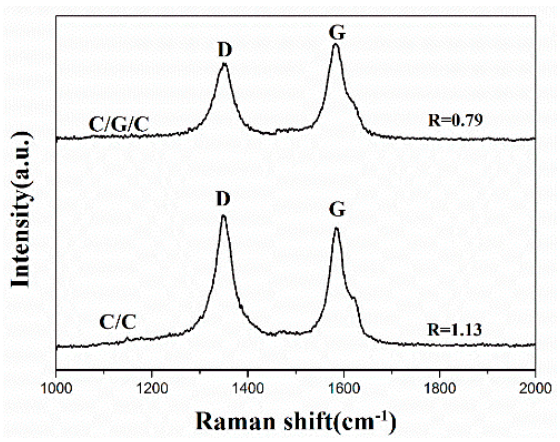
Figure 7. Raman spectra of the C/C and C/G/C composites.